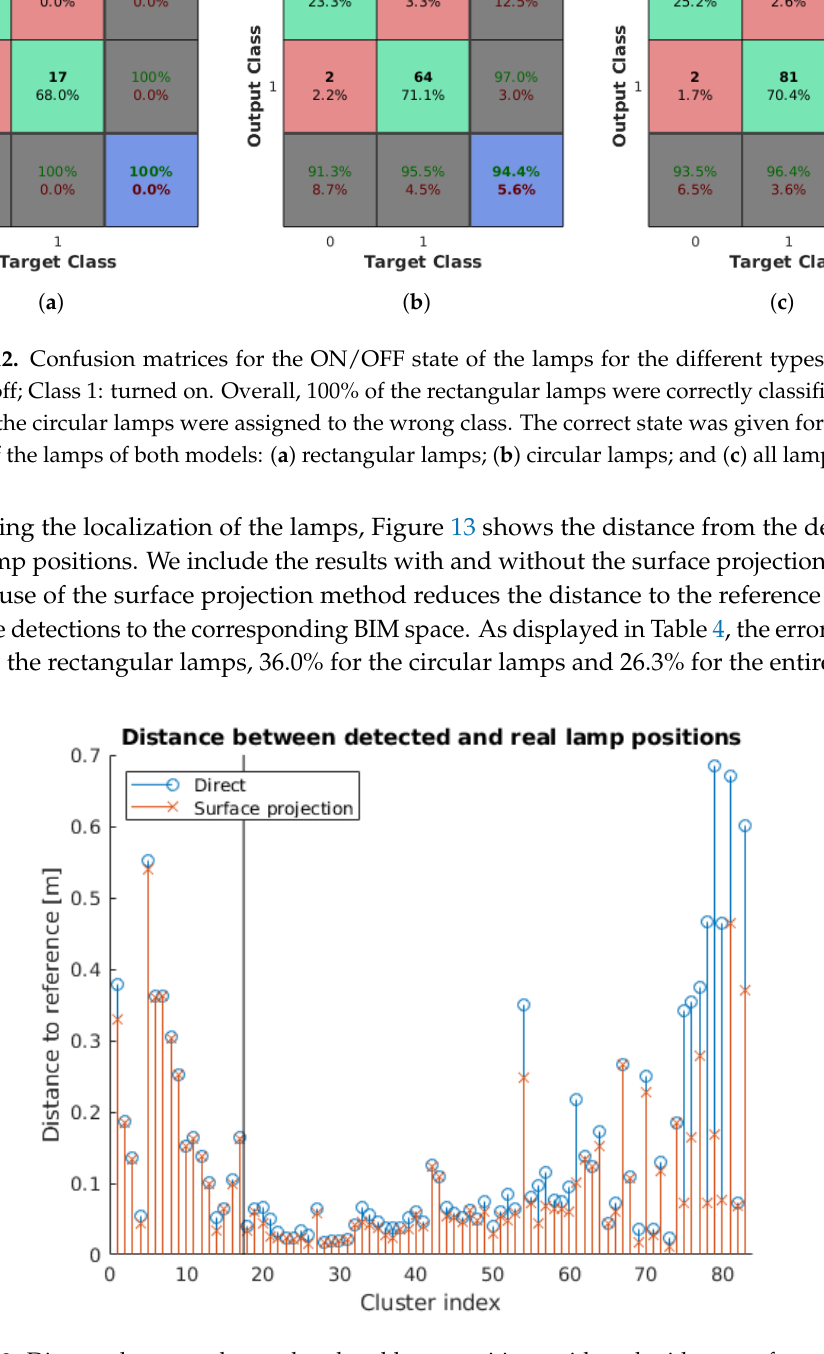
Figure 13. Distance between detected and real lamp positions with and without surface projection. The use of the surface projection step reduces the location error for all the detected